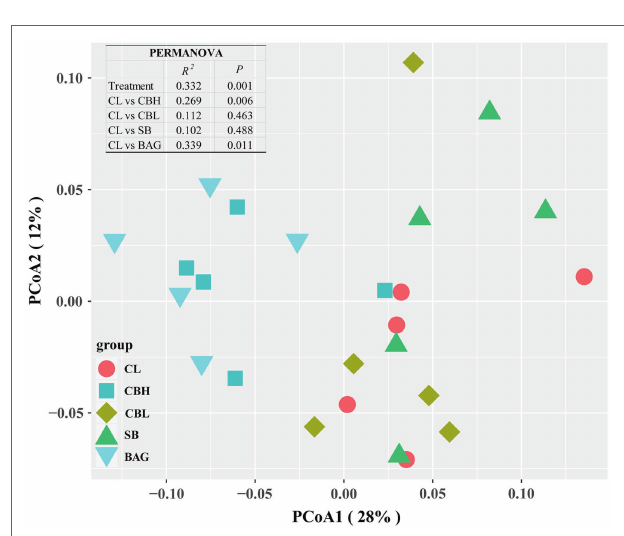
FIGURE 2 | Principal coordinates analysis (PCoA) of microbial communities among treatment groups based on Bray-Curtis